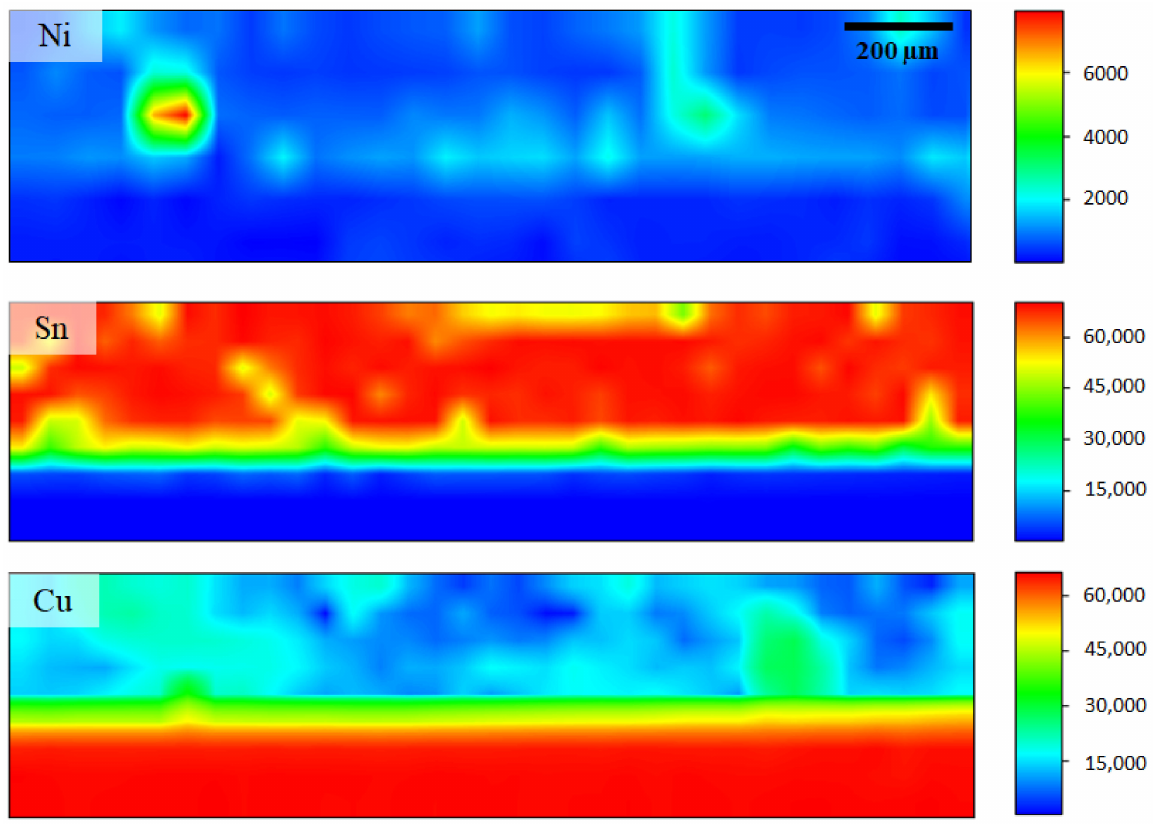
Figure 8. Elemental distribution of Sn-0.7Cu-0.05Ni on Cu